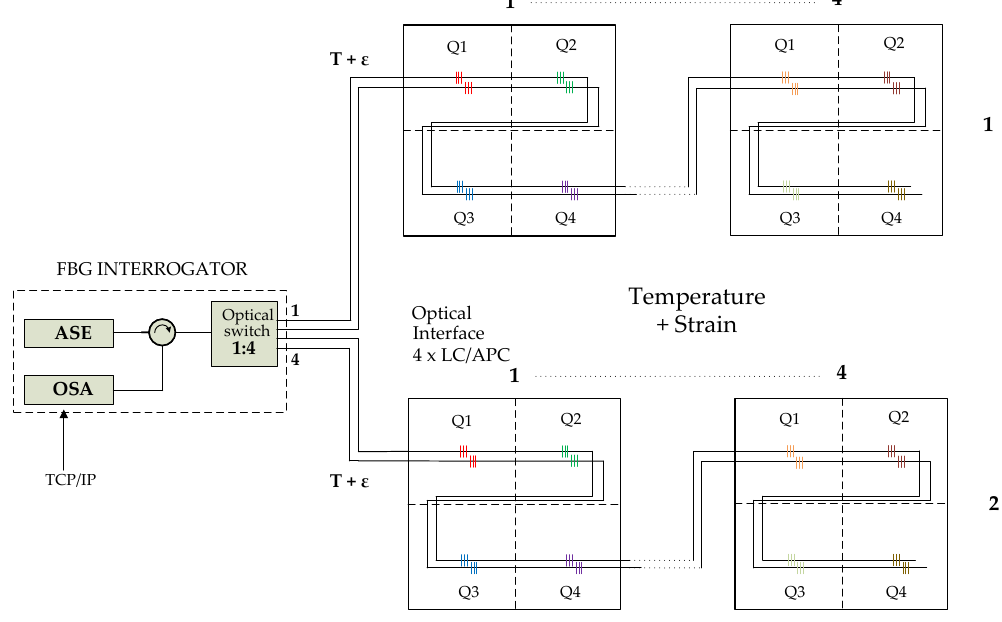
Figure 1. Whole concept of the